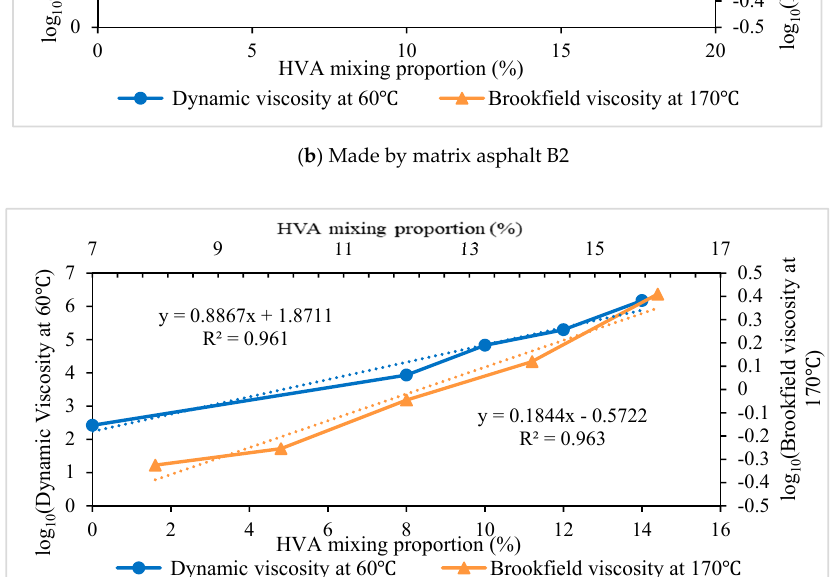
HVA mixing proportion (%) Dynamic viscosity at 60 ℃